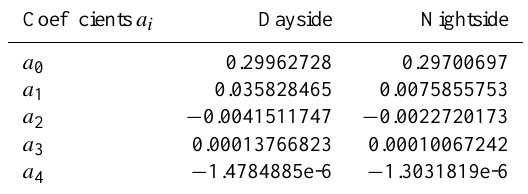
Table 1. Coefficients of the quartic function used to fit the peak frequency as a function of latitude in the dayside and nightside.